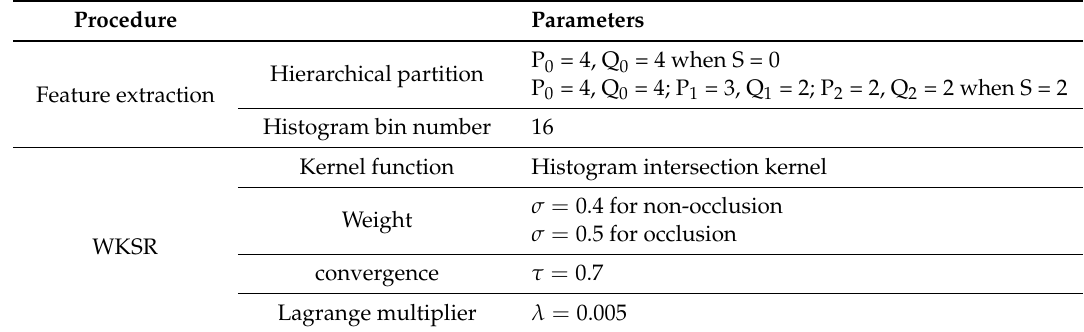
Table 2. Parameters of HFE − WKSR.